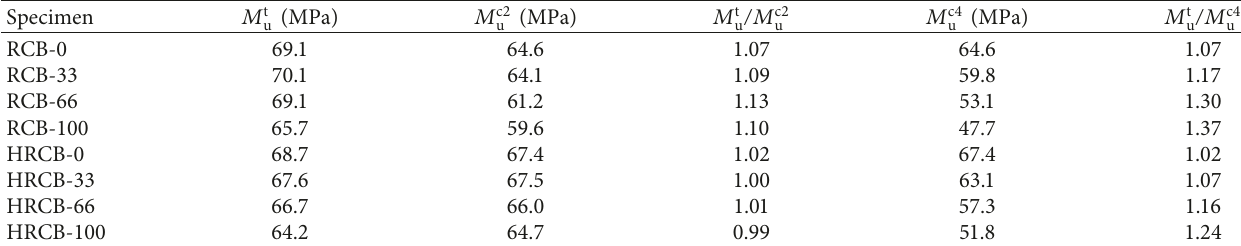
Table 7: Characteristic values of bearing